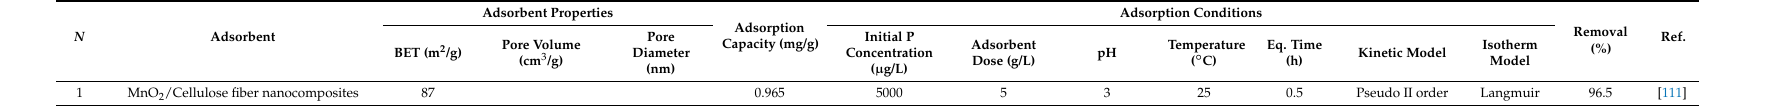
Table 16. Nanofibrous adsorbent properties and adsorption conditions for the removal of Toxaphene